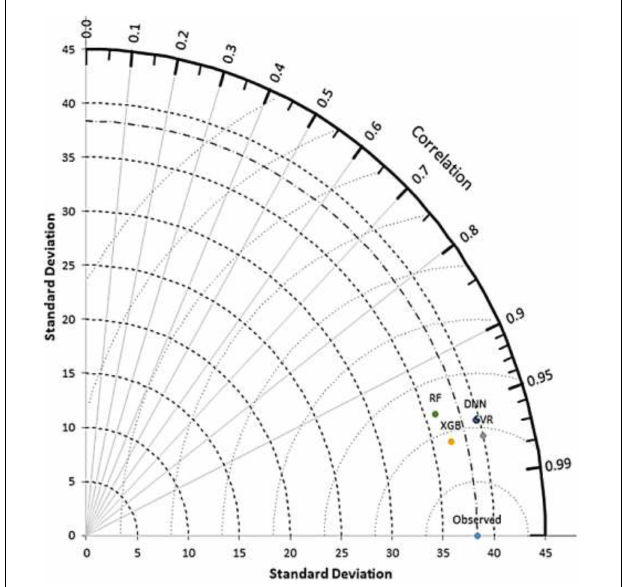
FIGURE 4 | Taylor diagram displaying a statistical comparison of the applied models used for predicting fresh head weight